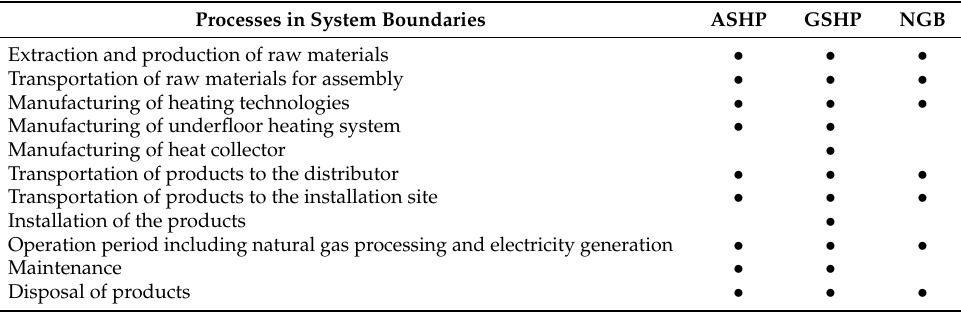
Table 2. Processes in system boundaries included for heat pumps and gas